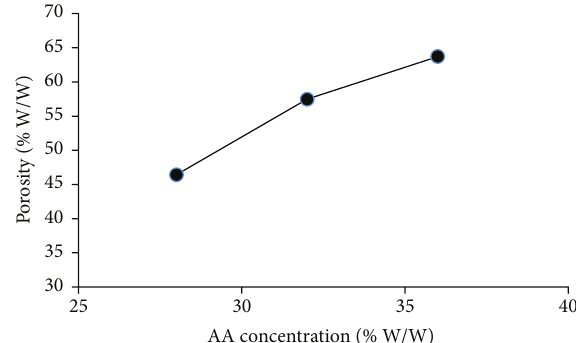
Figure 12: Effect of gelatin concentration on porosity of AA/Gelatin